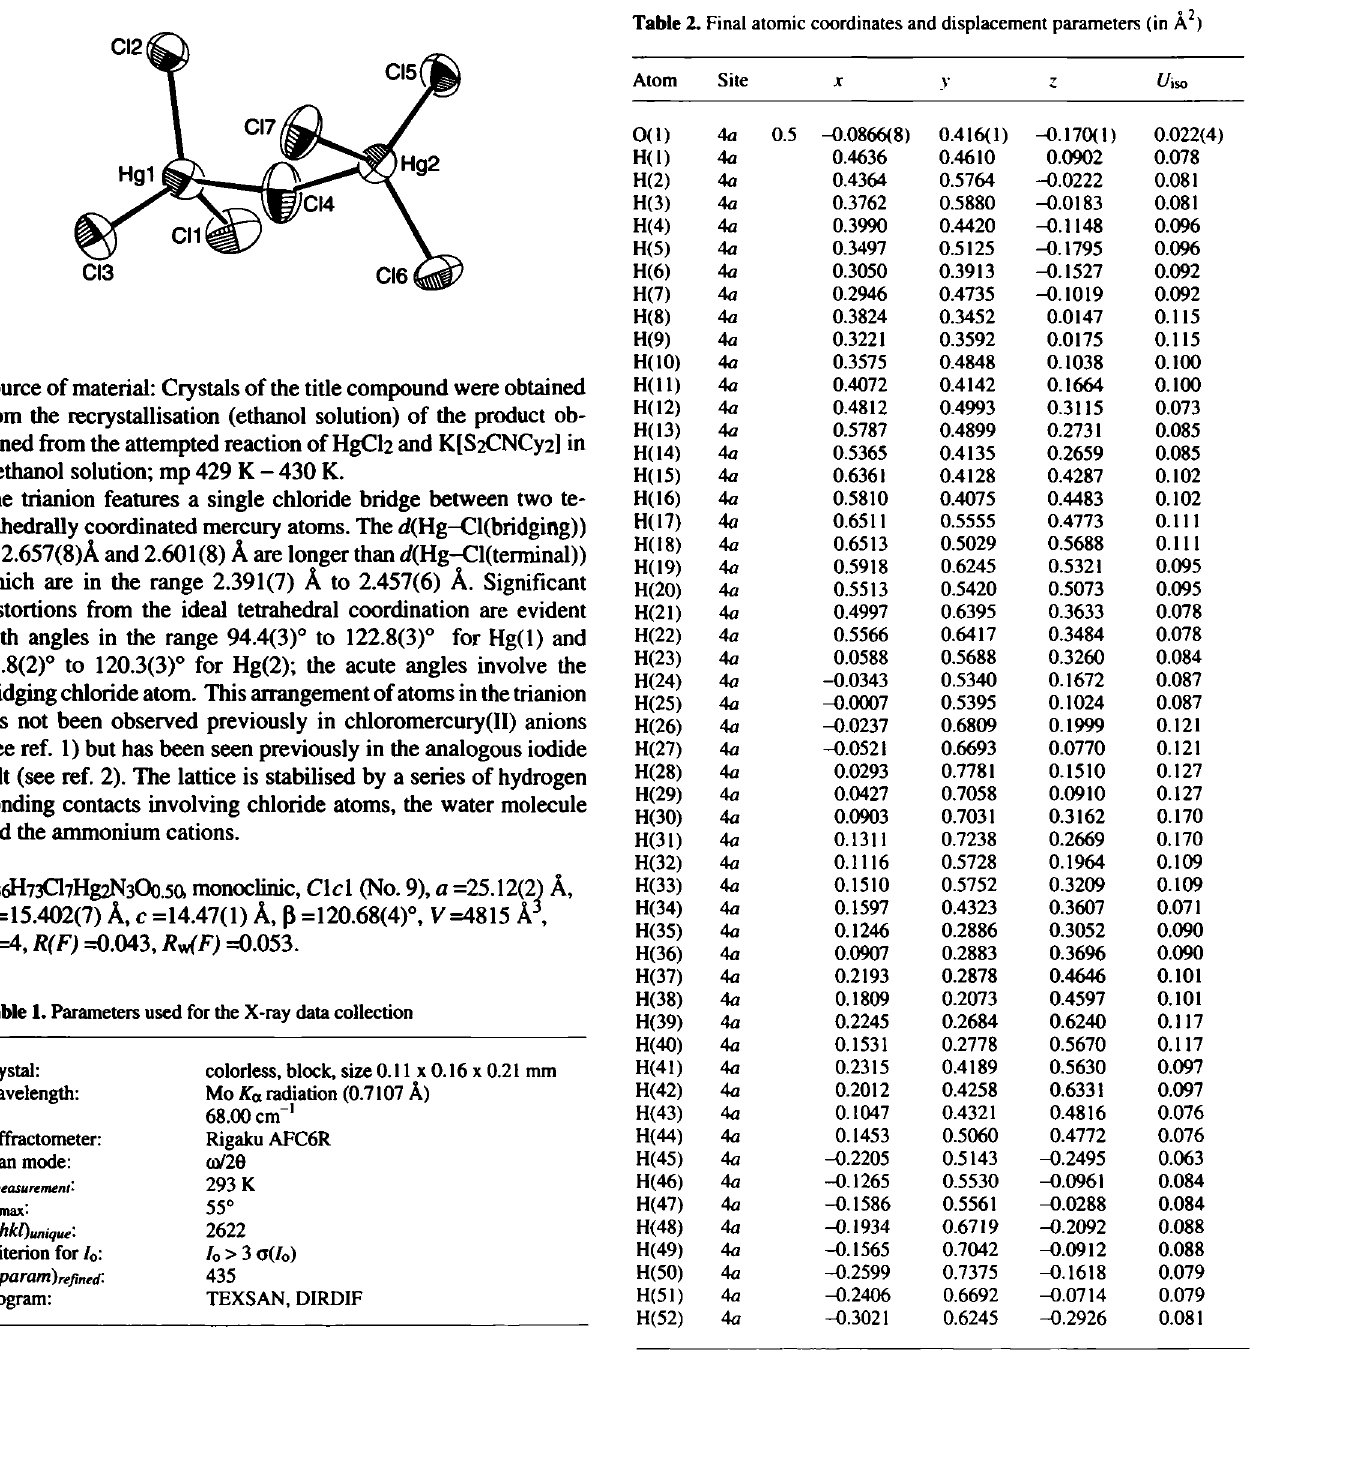
Table 2. Final atomic coordinates and displacement parameters (in